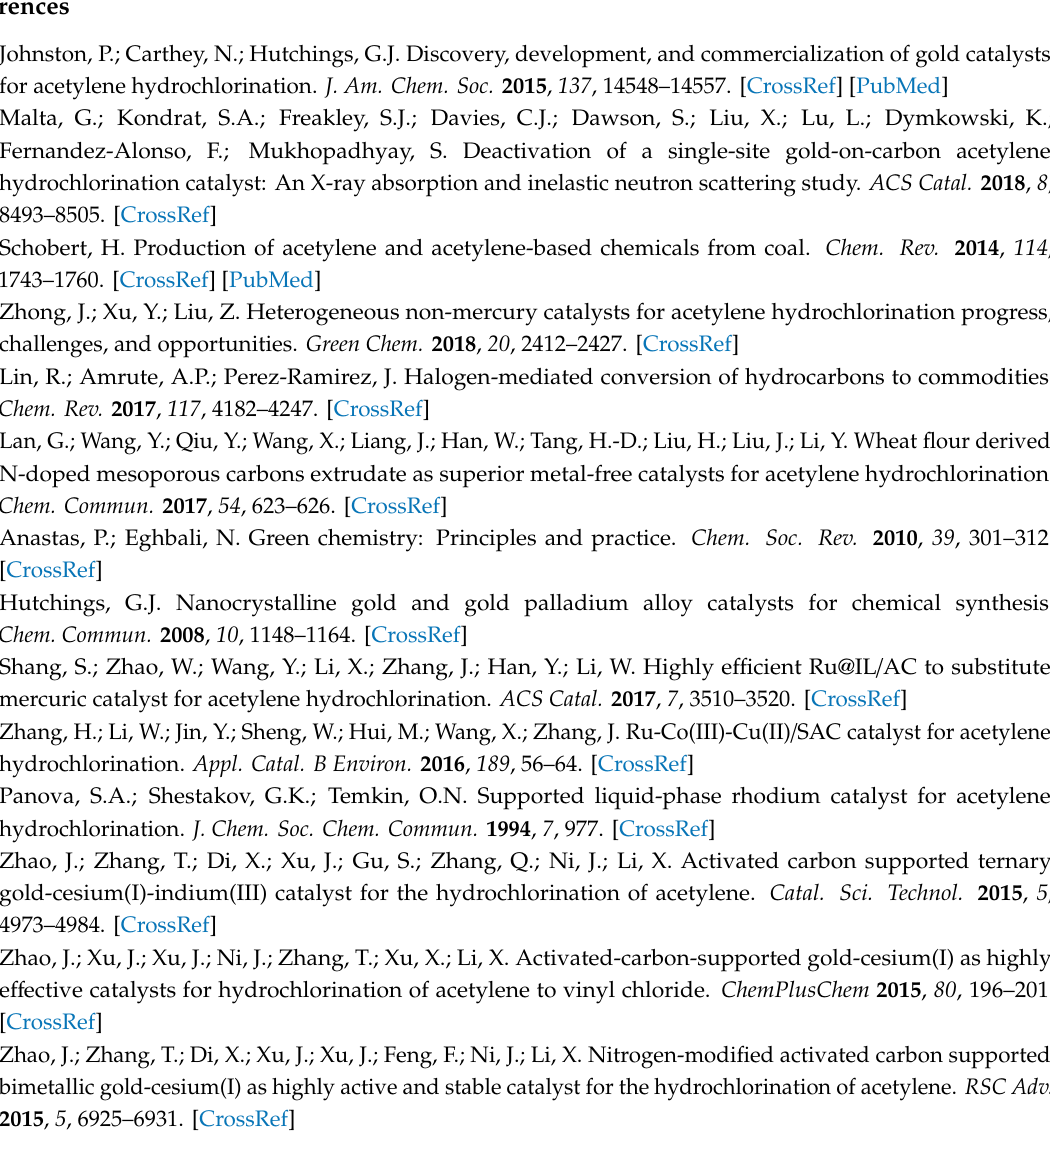
Figure S1: XRD results of fresh and used Pd / AC and Pd-IL / AC catalysts, Figure S2: XPS spectra of fresh and used Pd / AC and Pd-IL / AC catalysts, Figure S3: The electron density of ( a ) Pd-2A-IL; ( b ) Pd-2A-IL-C 2 H 2 ; ( c ) Pd-2A-IL-HCl, Figure S4: The electron density of ( a ) Pd-2EDA-IL; ( b ) Pd-2EDA-IL-C 2 H 2 ; ( c ) Pd-2EDA-IL-HCl, Figure S5: The electron density of ( a ) Pd-2PR-IL; ( b ) Pd-2PR-IL-C 2 H 2 ; ( c ) Pd-2PR-IL-HCl, Figure S6: The electron density of ( a ) Pd-2PD-IL; ( b ) Pd-2PD-IL-C 2 H 2 ; ( c ) Pd-2PD-IL-HCl, Table S1: The comparisons of catalytic performance of various catalysts reported in literatures. Table S2. Parameters for the C 2 H 2 and HCl molecules adsorption on Pd-based catalysts: adsorption energy (E ads ), bond length of the adsorbed molecule (d C-C or d H-Cl ). Table S3. Parameters for the C 2 H 2 and HCl molecules adsorption on Pd-based catalysts: Hirshfeld charge (C H ), bond length of the adsorbed molecule (d C-C or d H-Cl